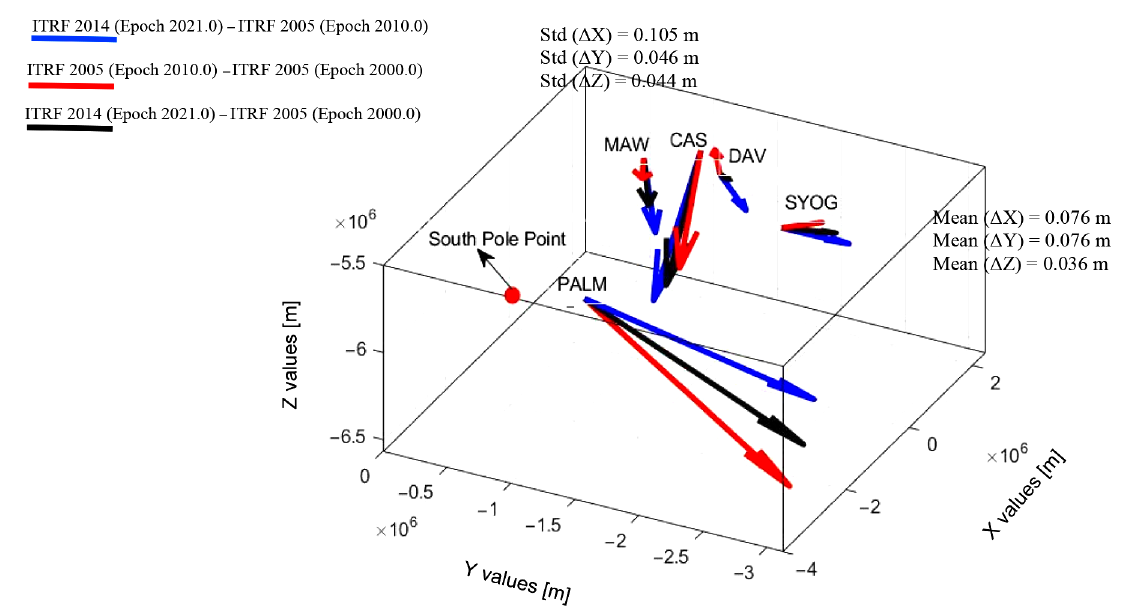
Figure 7. The three dimensional displacement vectors (WGS 84 coordinate system) for five IGS points in South Pole